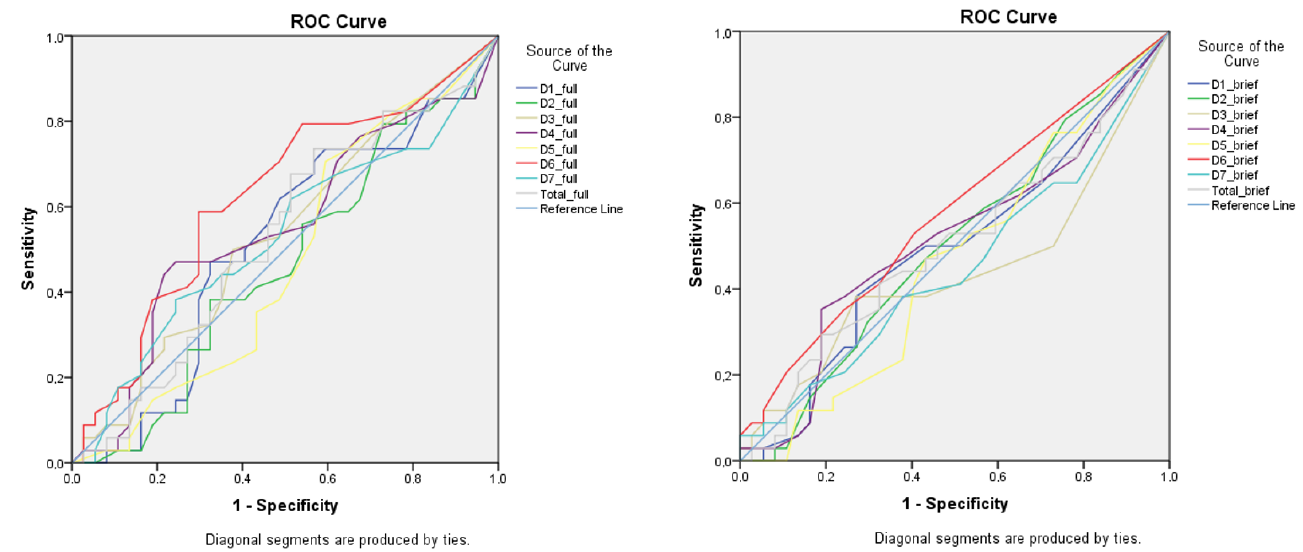
Table 4. Area under the ROC curve (AUC) of CaffEQ-BR full and brief versions for ADORA2A genotypes.